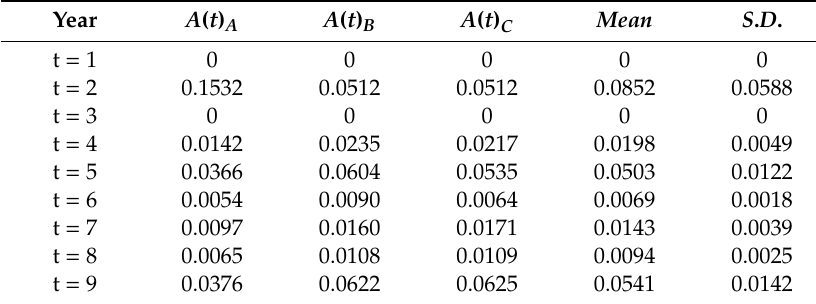
Table 1. Cost information for PPP schools (A$k).